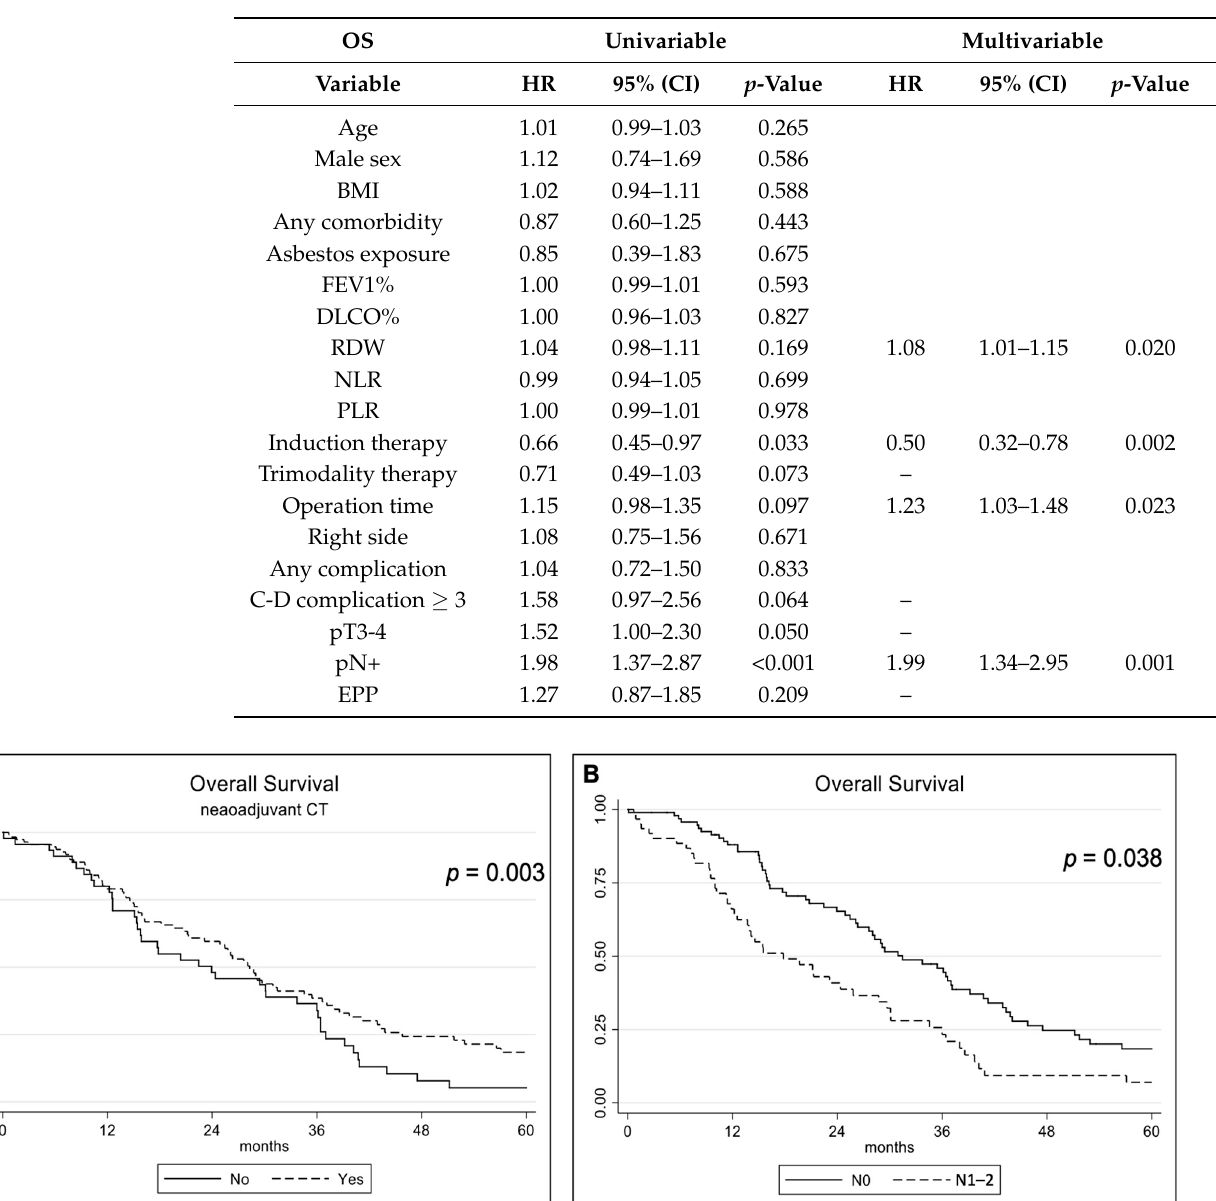
Table 4. Details of the statistical analyses: univariate and multivariate analyses for overall survival (Cox proportional hazards model).